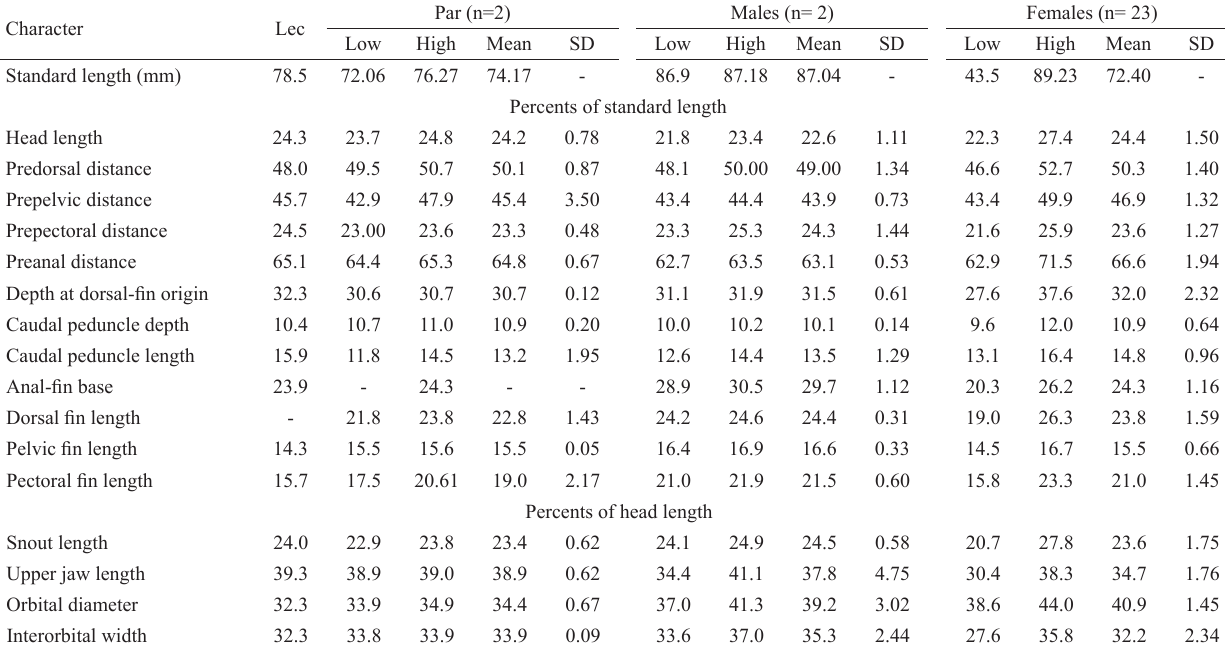
Tab. 2. Morphometric data for Deuterodon pedri , Lectotype (Lec), Paralectotypes (Par) and non-type specimens. SD = standard